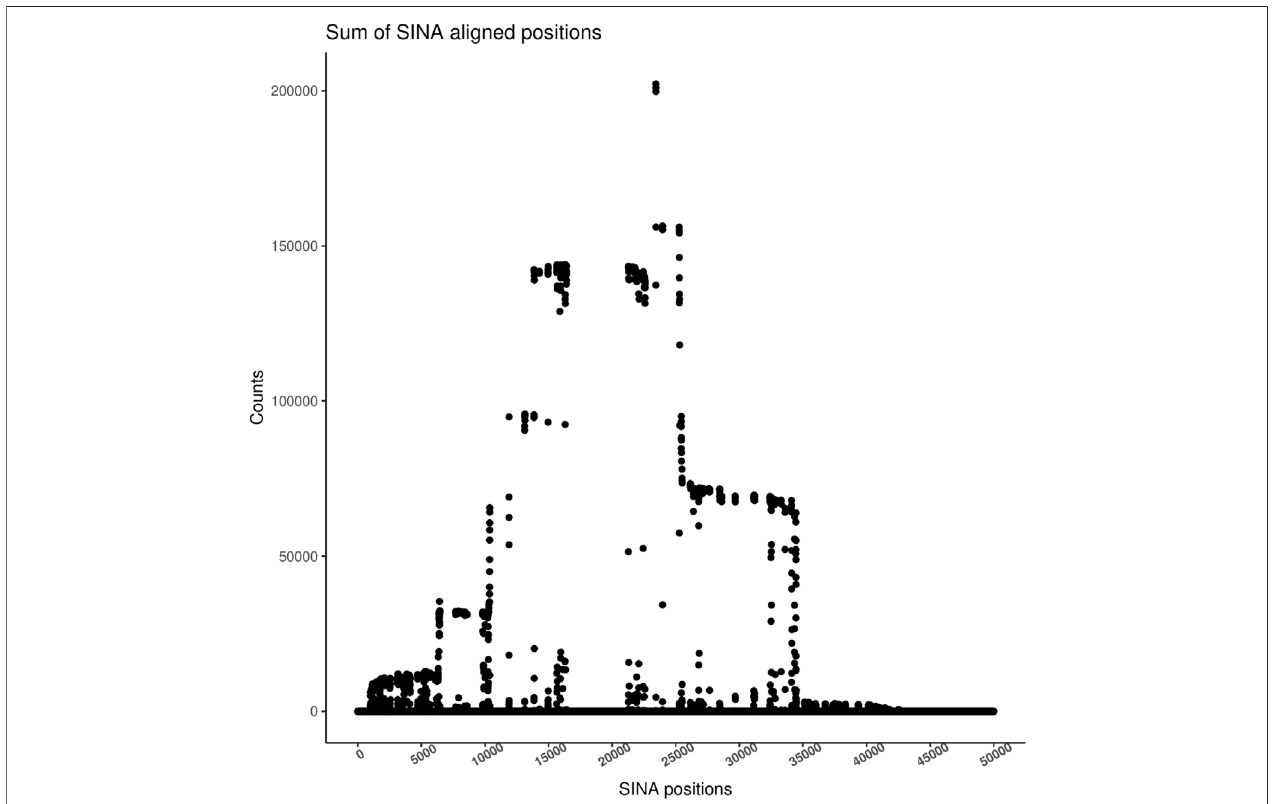
FIGURE3| Sum ofbasesoneach SINA alignment position. Theheight identi fi esthe region withthe mostcoverage inthe coverage plot. Guided bythisplot, users should select the target region for their analysis. All sequences will be trimmed around those positions, and only those containing a suf fi cient number of bases will be passed to the next